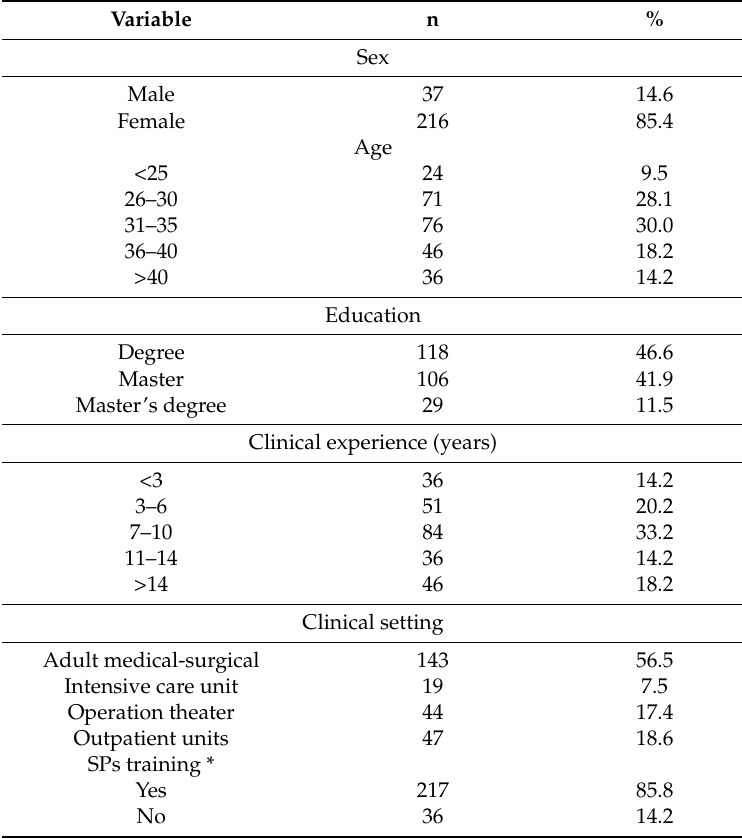
Table 1. Demographic characteristics of the sample (n =